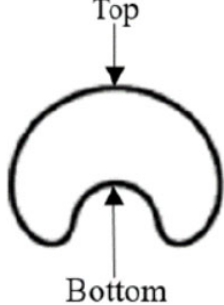
Figure 3. Schematic diagram of the top and bottom of the bubble in the literature.